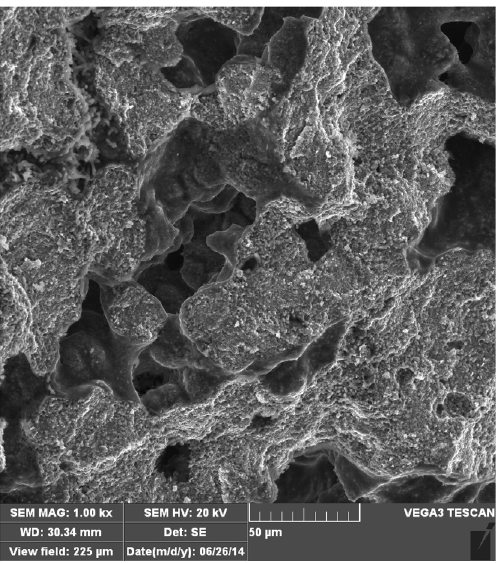
Figure 6: Fracture micrograph of the synthesized sample that con- tained 20 µm c-BN.